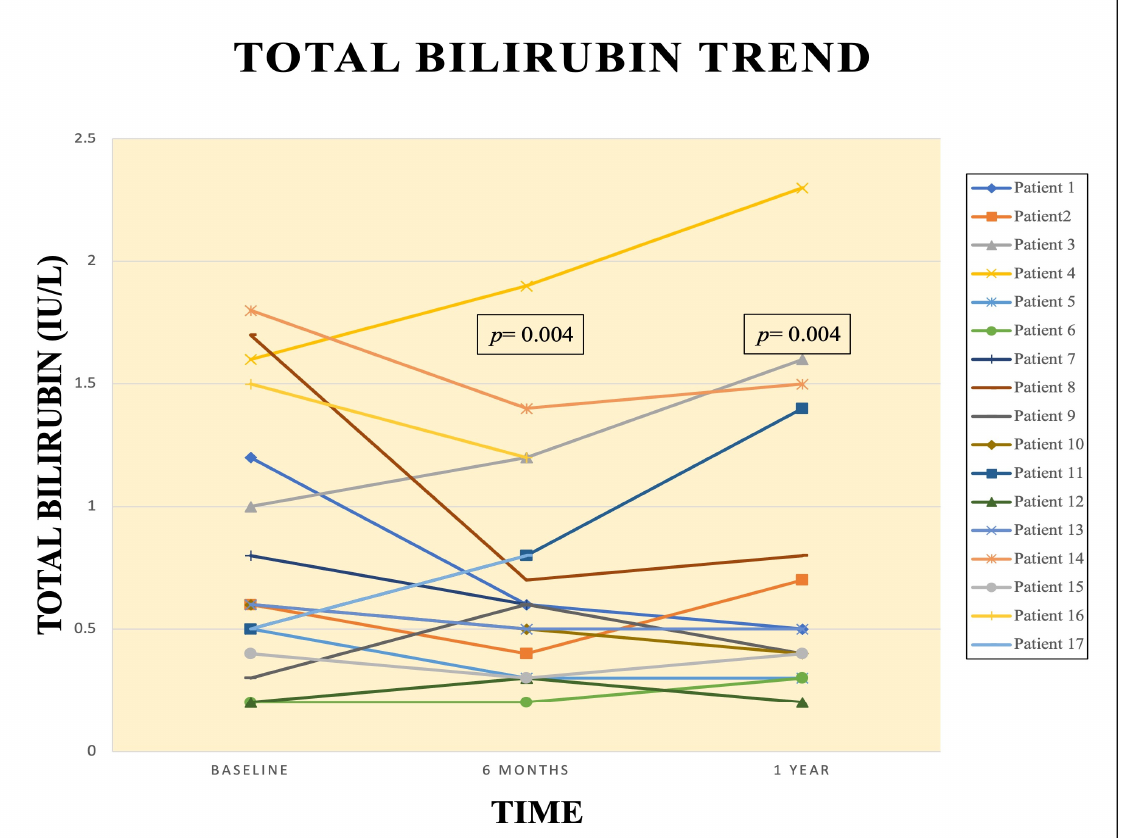
Figure 2. Total Bilirubin trends from baseline to 6-months and 1 year after initiation of Oral Vancomycin Therapy (OVT), p= 0.004.